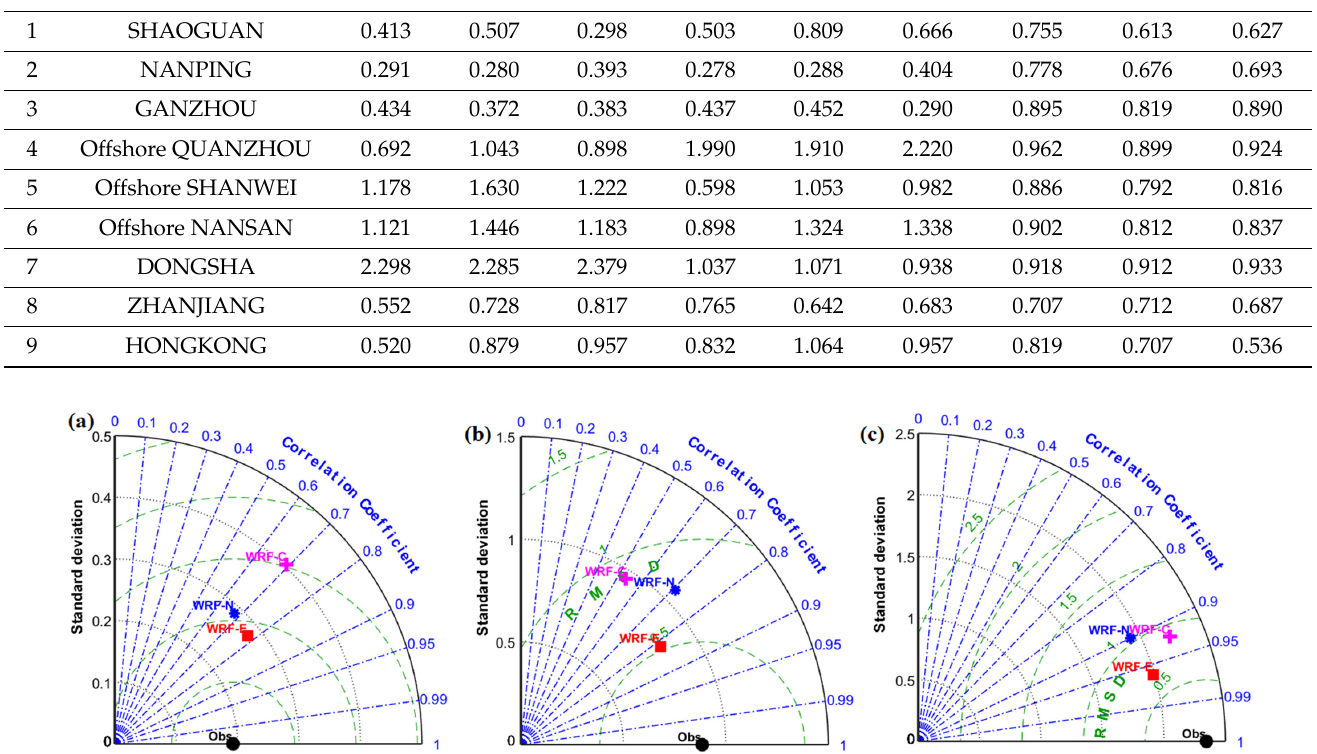
Figure 4. Taylor diagram for wind speed in m s − 1 from the models and observations at the locations ( a ) Nanping, ( b ) Hong Kong, and ( c ) offshore Quanzhou. Table 2. Statistics of wind speed at different locations.